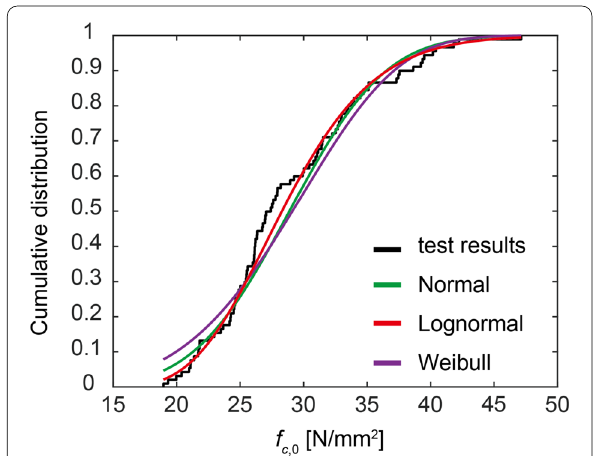
Fig. 11 Comparison of normal or Weibull distributions and tested compression strength distribution